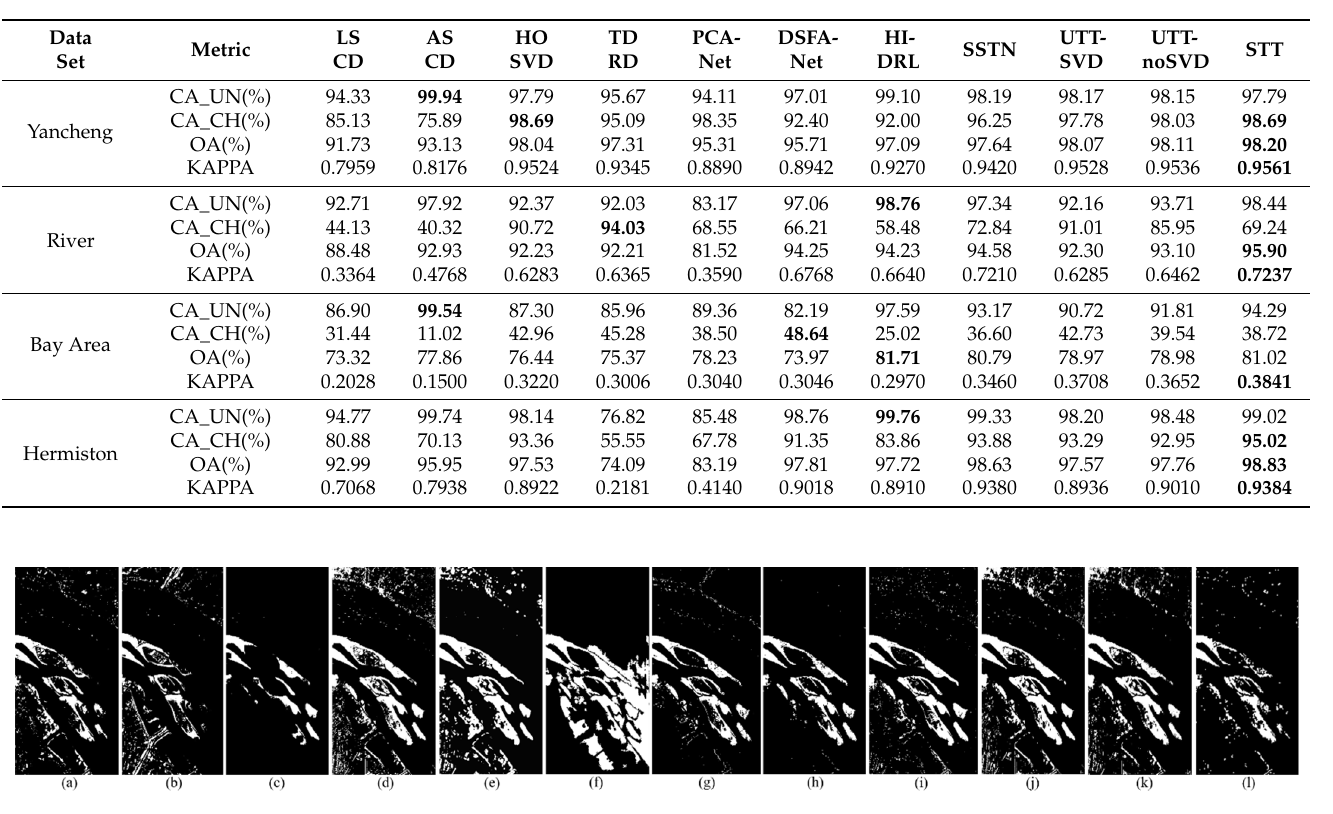
Figure 7. Binary detection results in the River dataset: ( a ) ground truth, ( b ) LSCD, ( c ) ASCD, ( d ) HOSVD, ( e ) TDRD, ( f ) PCANet, ( g ) DSFANet, ( h ) HI-DRL, ( i ) SSTN, ( j ) UTT-SVD, ( k ) UTT-noSVD, and ( l ) STT.